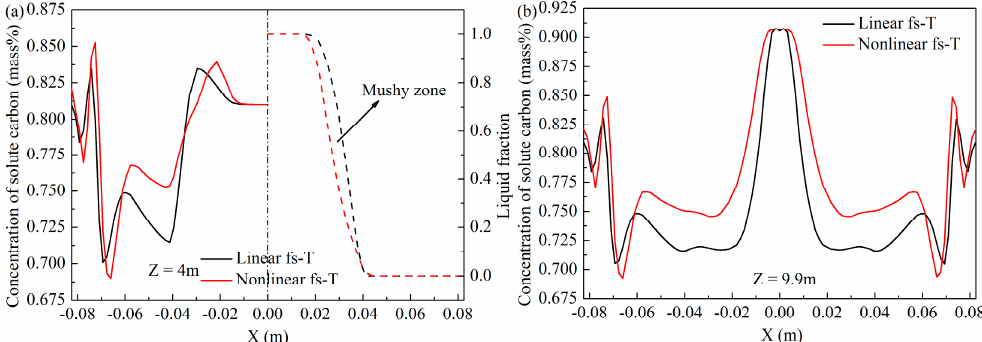
Figure 11. Comparison between the results calculated with linear and nonlinear fs-T functions: ( a ) Z = 4 m; and ( b ) Z = 9.9 m.